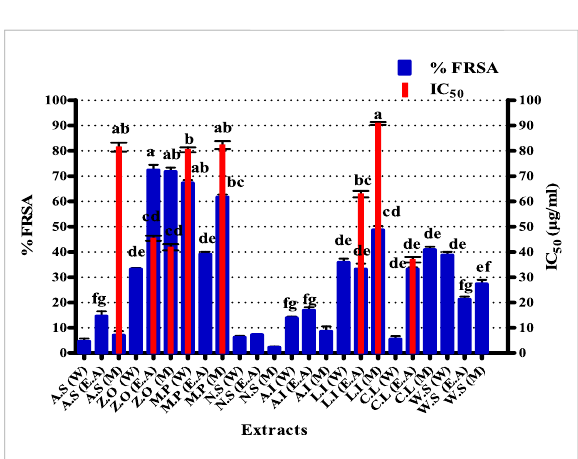
FIGURE 1 Free radical scavenging activity of test extracts. Values (mean ± SD) are the average of the triplicate analysis of each plant extract ( n value of 1 × 3). The columns with different superscript (a-g) letters show signi fi cantly ( p < 0.05) different means. FRSA, free radical scavenging activity; A. S, Allium sativum ; Z. O, Zingiber of fi cinale ; M. P, Mentha piperita ; N. S, Nigella sativa ; L. I, Lawsonia inermis; C. L, Curcuma longa ; W. S, Withania somnifera